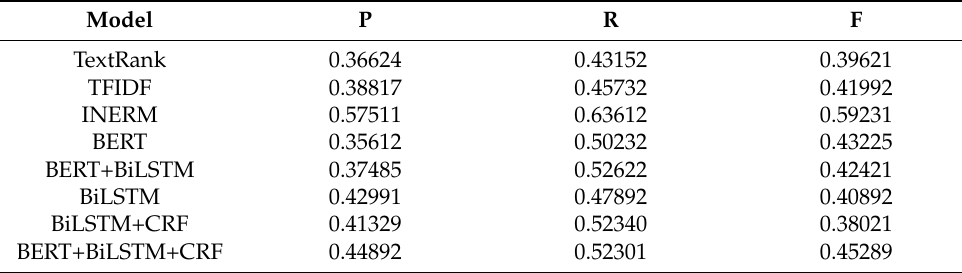
Table 4. Comparison of various algorithm models on the test set. Model P R F